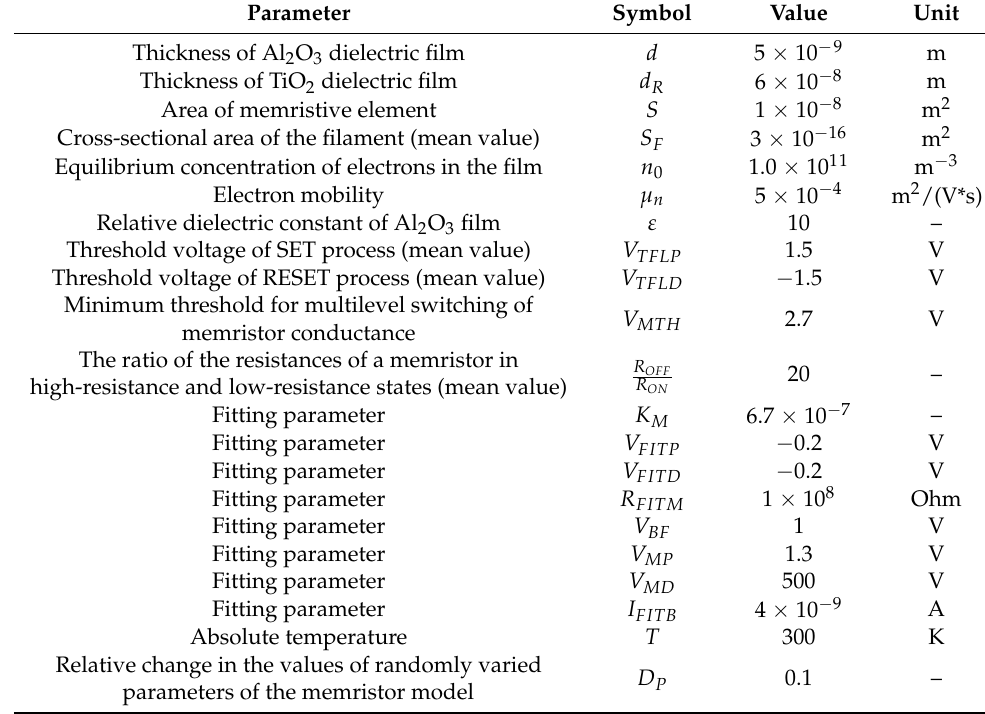
( d ) Figure 8. I–V characteristics of a memristive element with multilevel conductivity tuning without taking into account ( a ) and taking into account ( b ) the statistical variation of parameters, comparison of the simulation results ( c ) with the measurement data ( d ) [27] for the memristive structure shown in Figure 2b (measurements were carried out for one sample of the memristor structure).